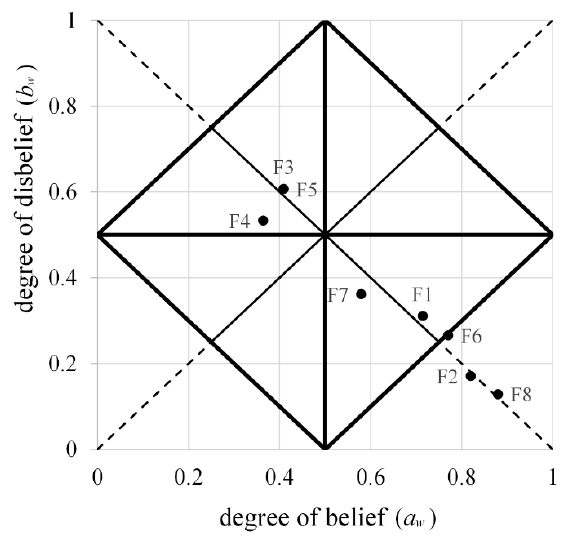
Figure 7. Air-oil accumulator example Unitary Square on the Cartesian Plane (USCP).